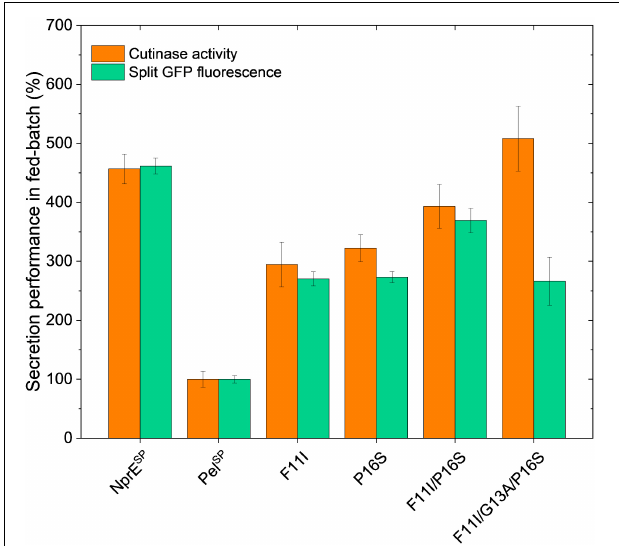
FIGURE 5 | Fed-batch of C. glutamicum K9 biosensor cells harboring different recombinant plasmids for secretory production of cutinase-GFP11. Biosensor cells carrying pPBEx2-NprE-cutinase-GFP11 (NprE SP ), pPBEx2-Pel-cutinase-GFP11 (Pel SP ) or the Pel SP variants F11I, P16S, F11I/P16S or F11I/G13A/P16S were cultivated in a BioLector Pro at 30 ◦ C, 1,400 rpm, ≥ 30% headspace oxygen and ≥ 85% relative humidity. For the fed-batch process, CGXII medium with an initial glucose concentration of 5 g/L was inoculated to an OD 600 of 0.5 from the respective precultures. After 10 h, glucose was fed with a constant rate of 5.22 µ L/h (equals 2.09 mg/h glucose). Regulation of pH to a set point of 6.8 was performed with 3 M